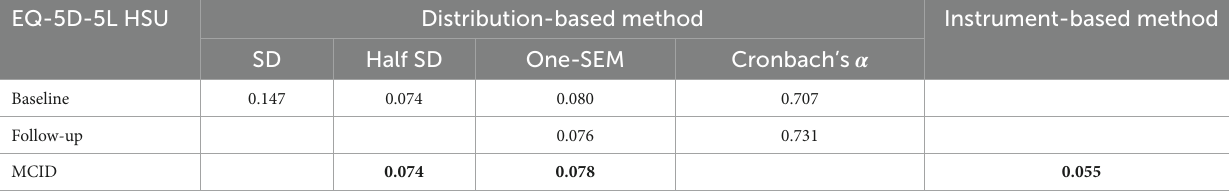
TABLE 7 Minimal clinically important difference (MCIDs) of the EQ-5D-5L HSU through different methods and the relation to the MDC at individual and group levels.